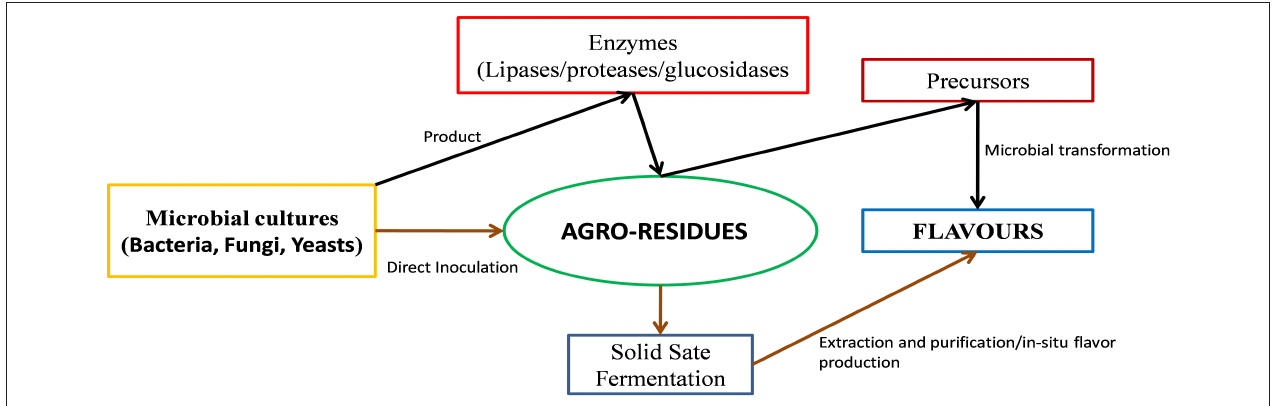
FIGURE 1 | Microbial production of bioflavors from